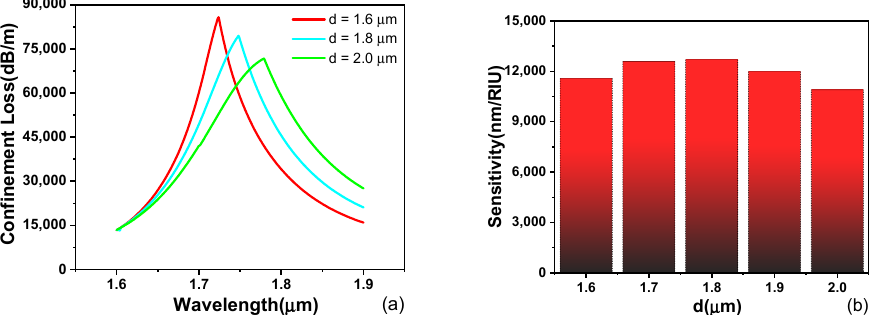
Figure 4. The loss spectra ( a ) and sensitivity ( b ) for various regular air holes’ diameters d. The other parameters are d 2 = 1 μ m, t ITO = 60 nm, h = 6.4 μ m, and n a = 1.38.